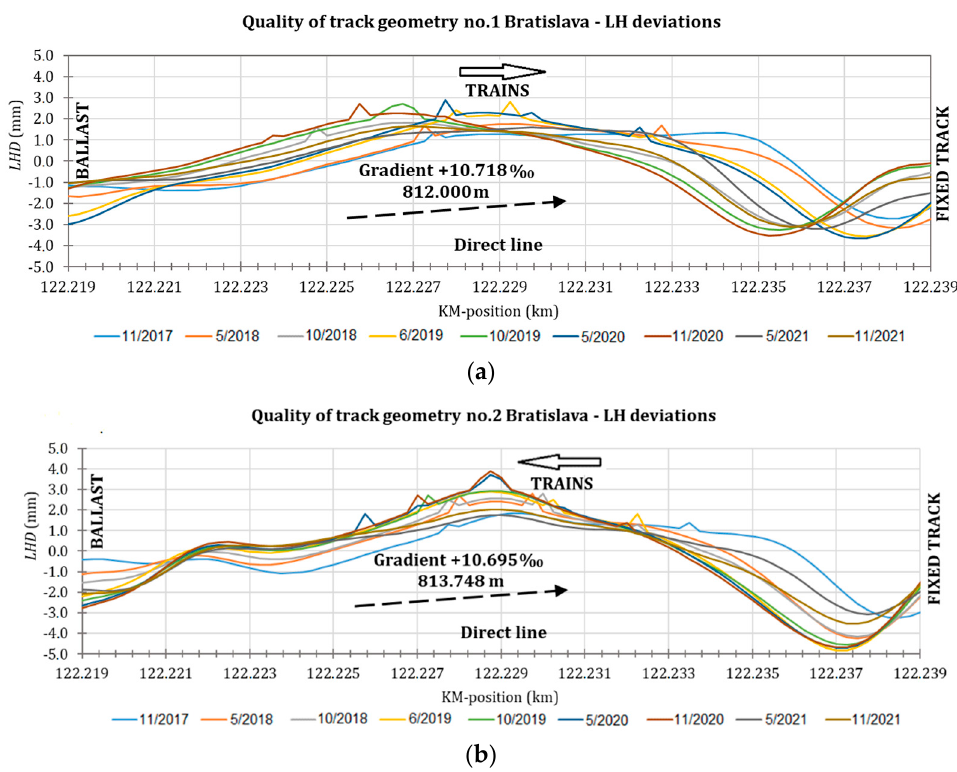
Figure 10. Quality of track geometry—longitudinal height deviations (LHD) of the transition zone, toward “Bratislava”: ( a ) Track axis no. 1; ( b ) Track axis no. 2.